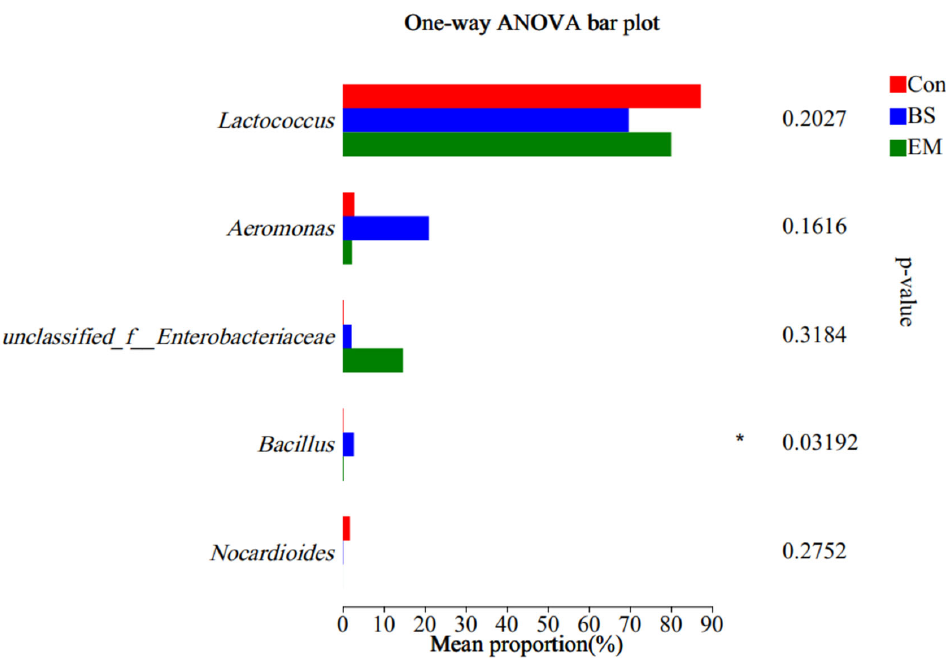
Figure 5. Analysis of significant differences in the dominant flora of the intestinal tract of M. rosenbergii at the genus level. Significance ( p < 0.05) indicated by *.